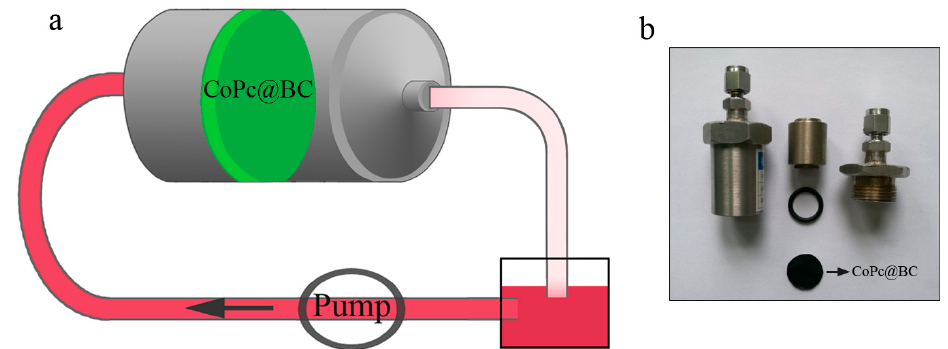
Figure 2. ( a ) Schematic representation of the CoPc@BC-based catalytic membrane reactor (CMR); ( b ) Optical image of the CoPc@BC-based CMR.